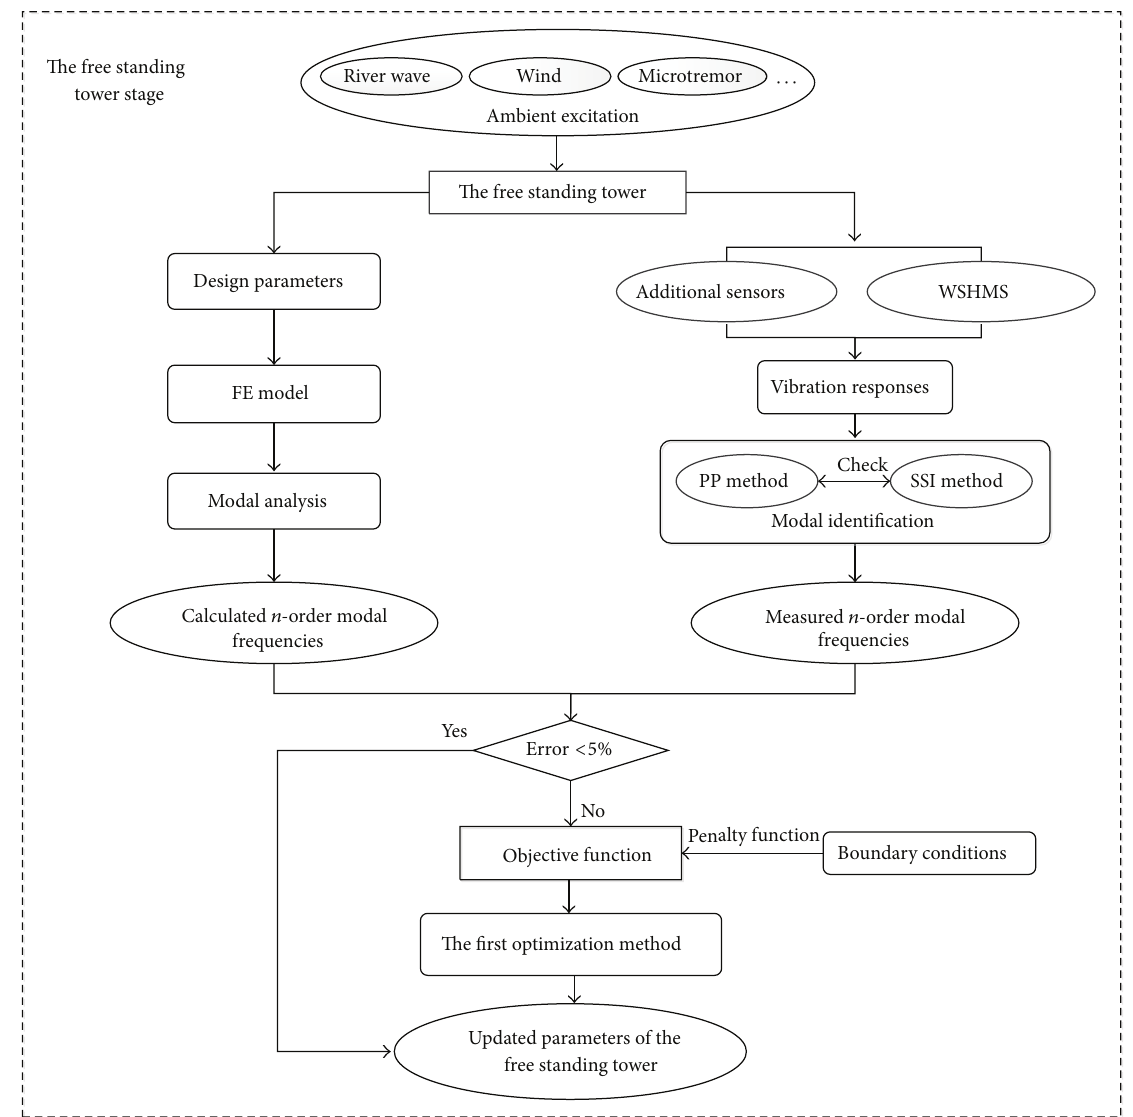
Figure 11: FE model updating of the free standing tower